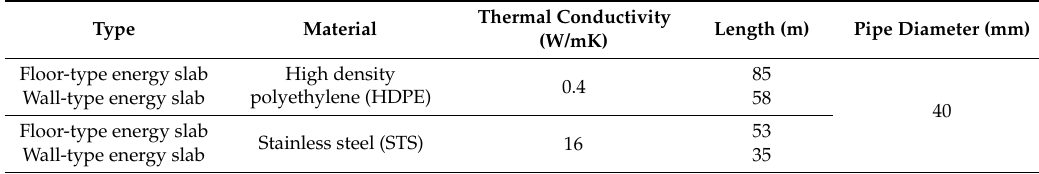
Table 1. Length and thermal conductivity of each heat exchange